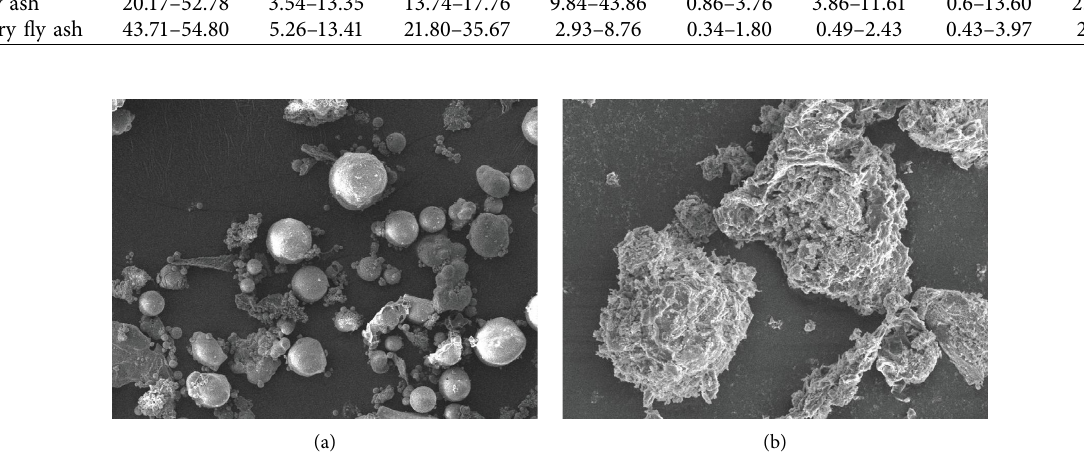
Figure 1: SEM images of particles of (a) ordinary fy ash and (b) CFB fy ash.